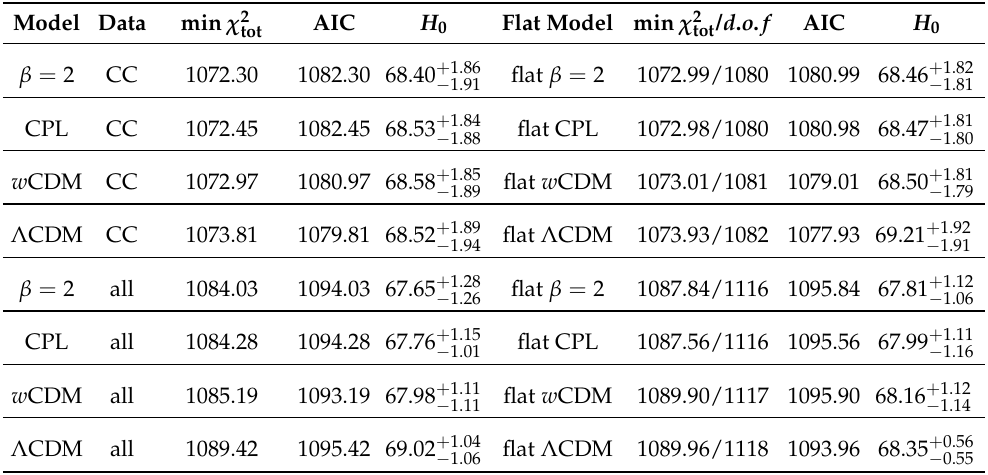
H 0 for the models β = 2 (32), CPL (23), w CDM, Λ CDM, Table 3. The best fits of min χ 2 tot , AIC, and and these models in the spatially flat case ( k =